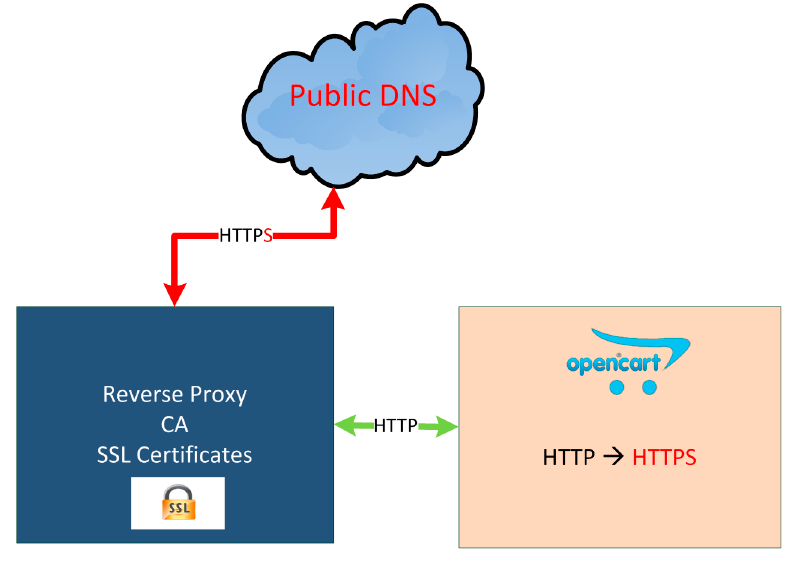
Figure 11. Https access.